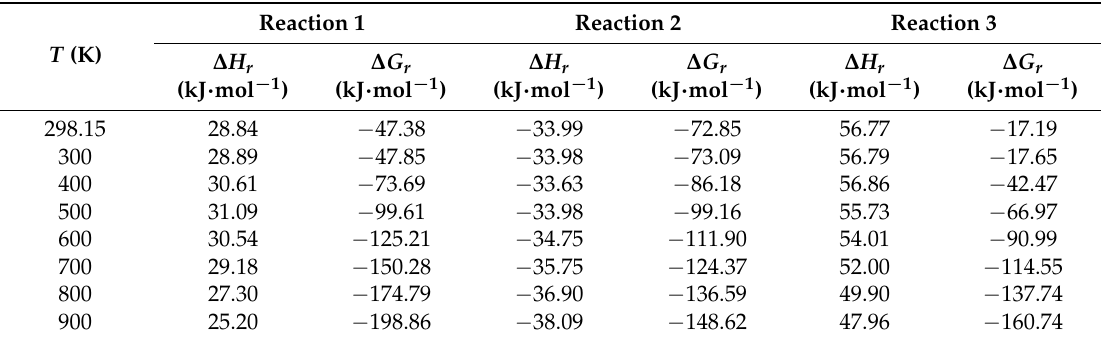
Table 3. Reaction Enthalpy and change of Gibbs free energy as a function of reaction temperature for each reaction.